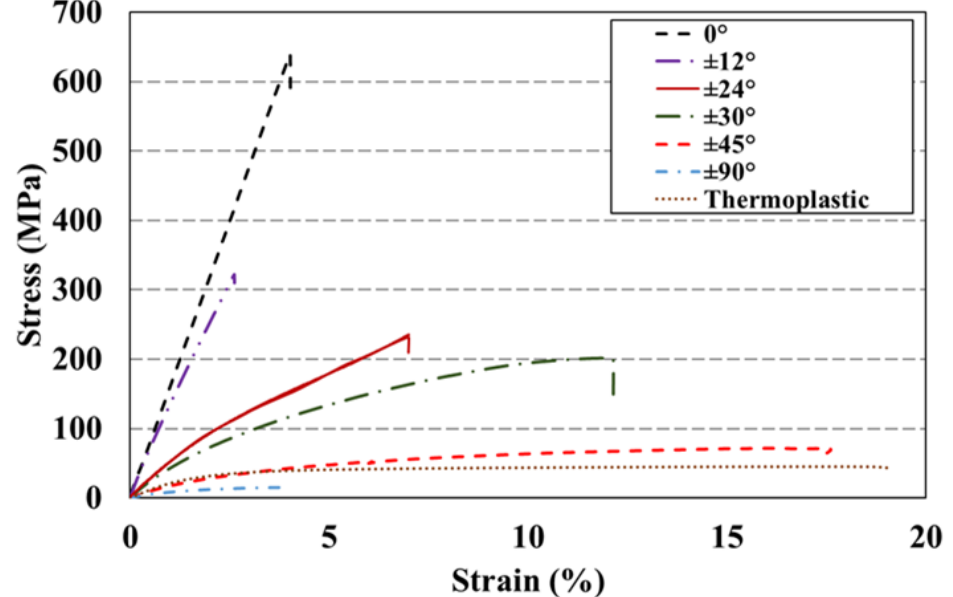
Figure 5. Median tensile stress-strain curves (out of five specimens) for single-angled 3D-printed GFRP composite specimens (Set 1) and 3D-printed thermoplastic specimen. Table 3. Tensile properties of single-angled 3D-printed GFRP composite specimens (Set 1) and 3D- printed thermoplastic specimens.